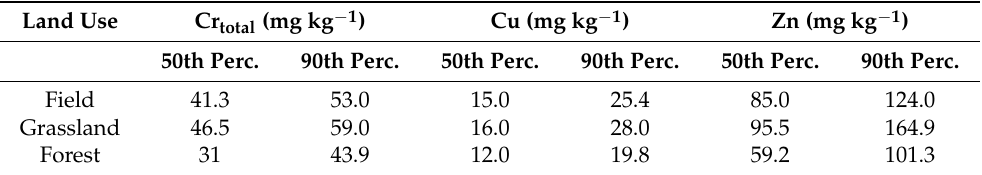
Table 7. Here, 50th and 90th percentile (perc.) of the Luxembourg background database for chromium, copper and zinc by land use, after elimination of special cases and